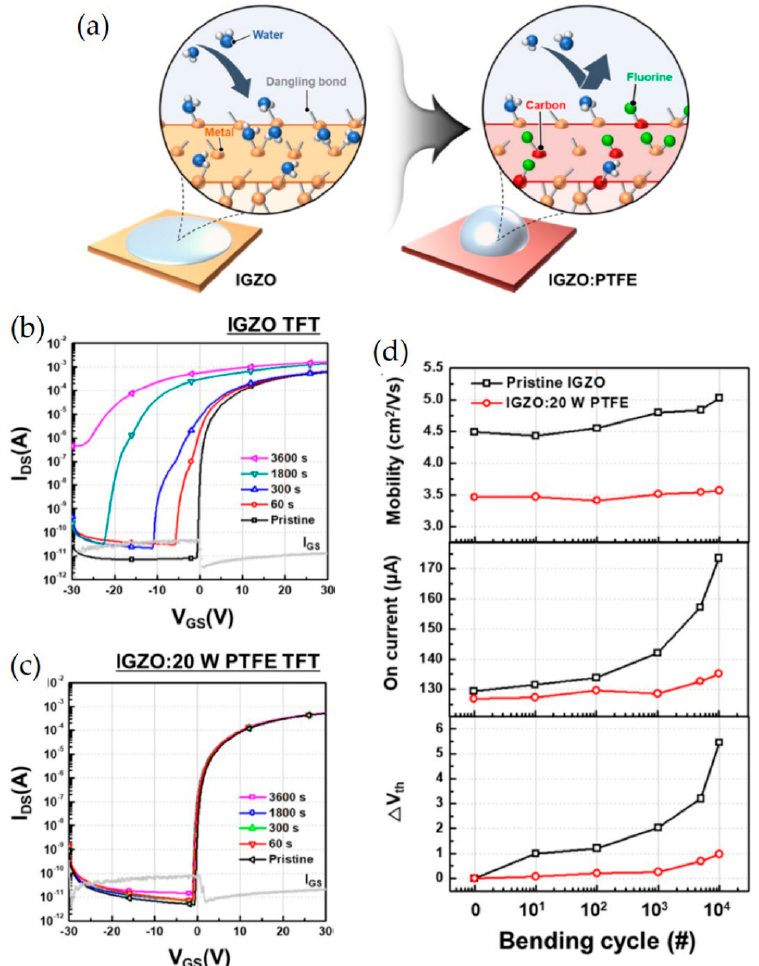
Figure 5. ( a ) Schematic illustration of improved hydrophobicity of the IGZO: PTFE film. Transfer characteristics of ( b ) the IGZO TFT and ( c ) the IGZO: 20 W PTFE TFT upon exposure to water for di ff erent times. ( d ) Variations of mobility ( µ FE ), on-current, and V th for IGZO and IGZO: 20 W PTFE TFTs with respect to bending cycles. Reproduced permission from [95], Copyright, 2018, American Chemical